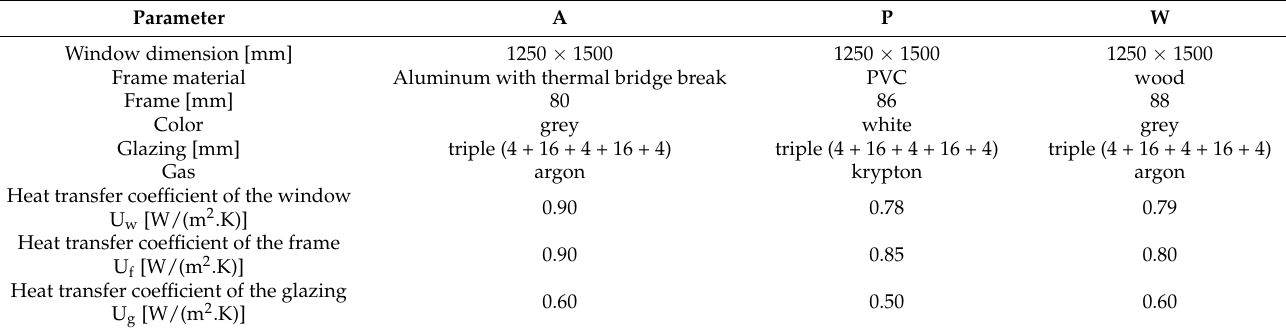
Figure 3. Plan of the pavilion laboratory. Table 1. Parameters of window construction.